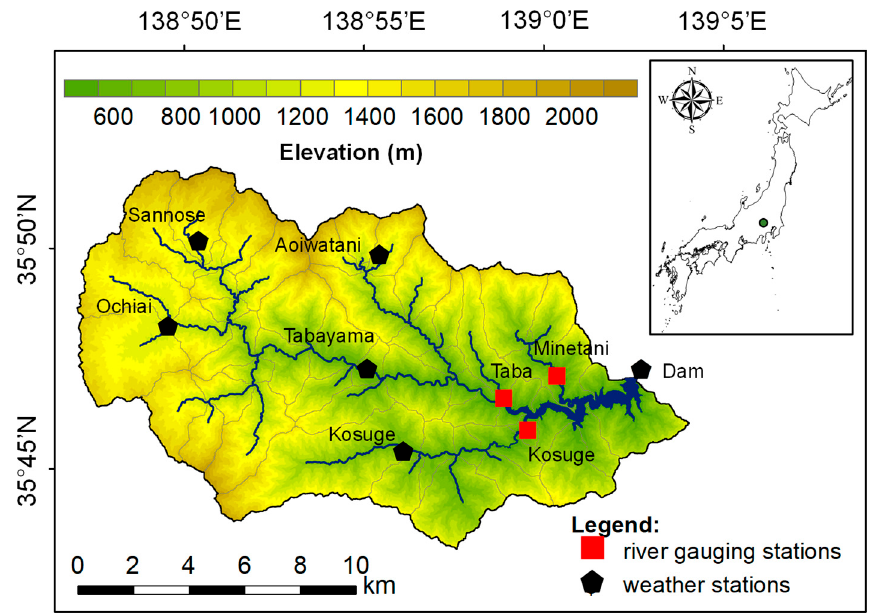
Figure 1. Digital elevation model (DEM) and locations of river gauging and weather stations in the Ogouchi Dam watershed in Japan.